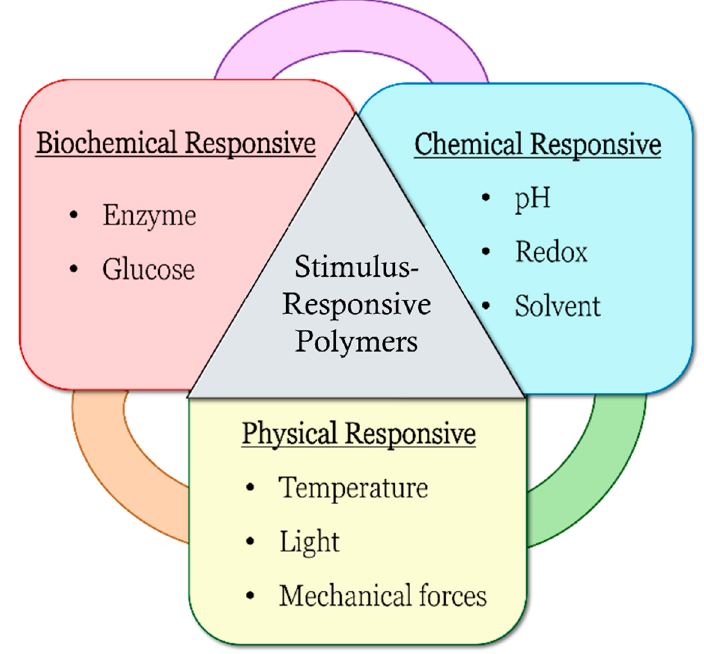
Figure 1. Types of stimulus-responsive polymers.